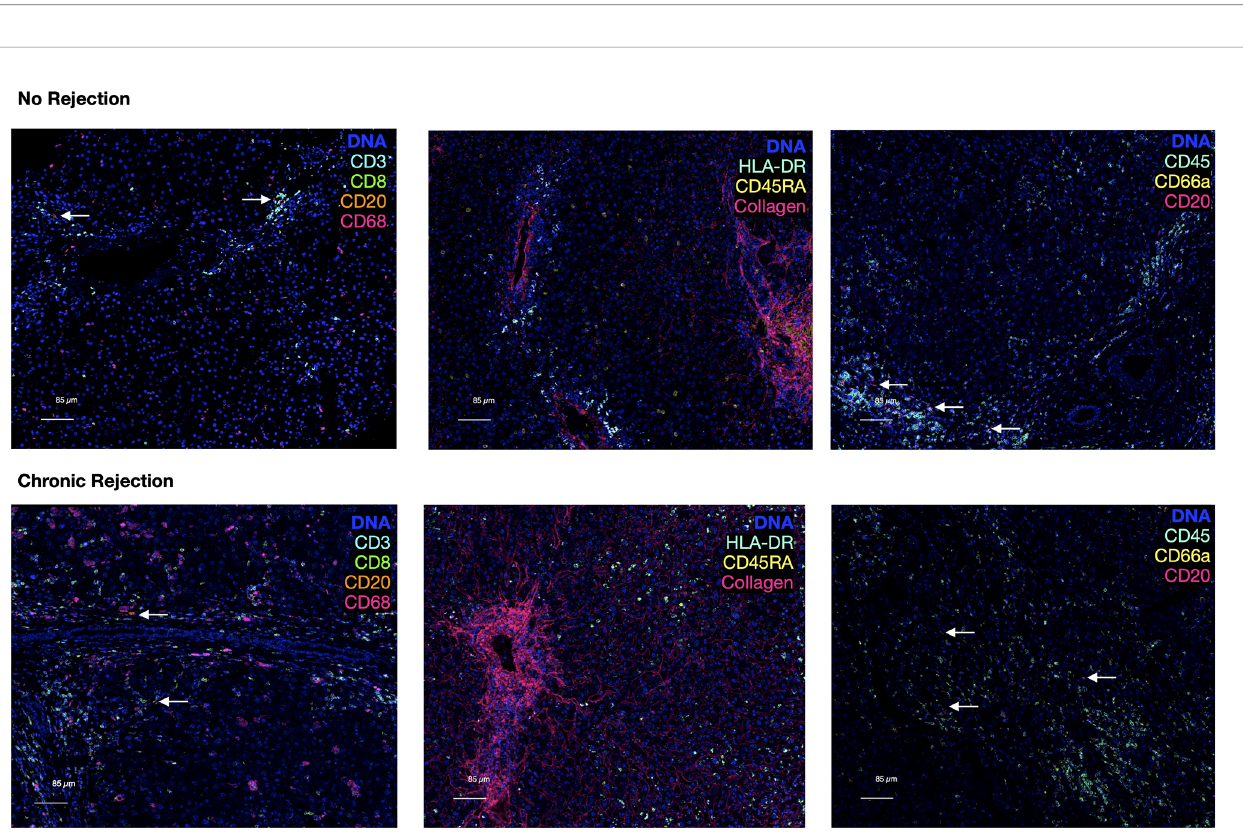
FIGURE 2 | Representative pseudocolored images of IMC markers in liver with no rejection versus chronic rejection post-transplant. Antigens targeted by the isotope- conjugated antibodies of the 10 marker IMC panel that was used to stain liver tissue with no rejection and liver transplant recipients with chronic rejection. These are representative IMC images from the analyzed cohorts generated by IMC. A DNA intercalator dye (iridium) was used to identify nuclei. White arrows indicate rare CD20+